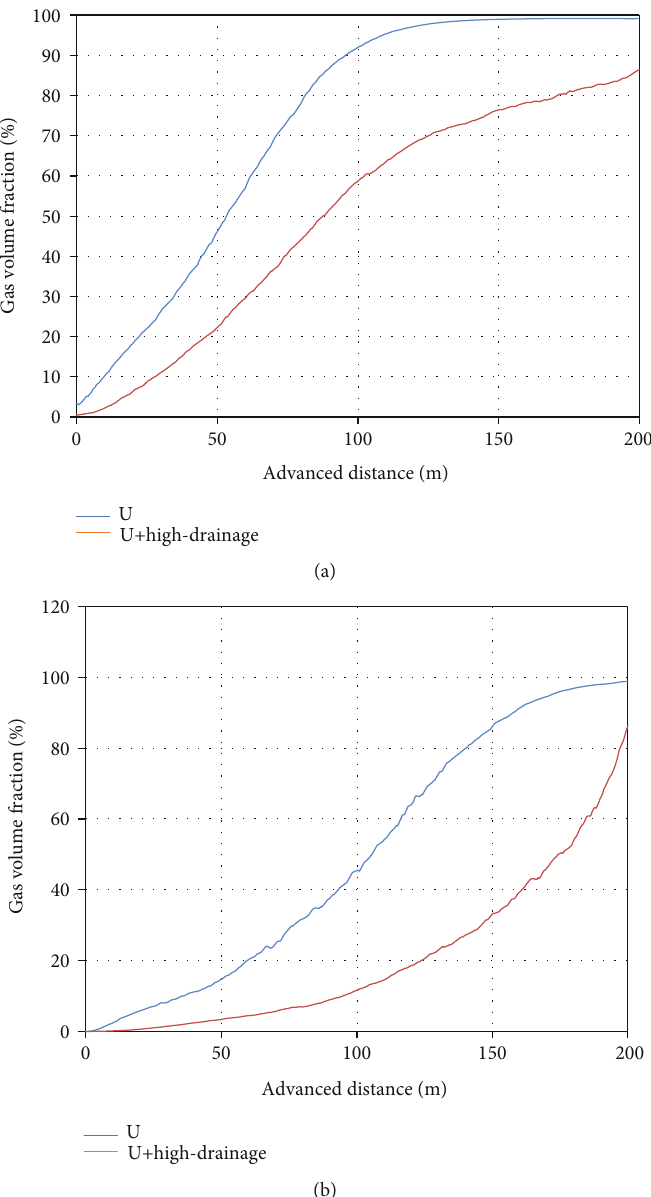
Figure 12: Volume fraction of gas in intake (a) and return (b) airway before and after high